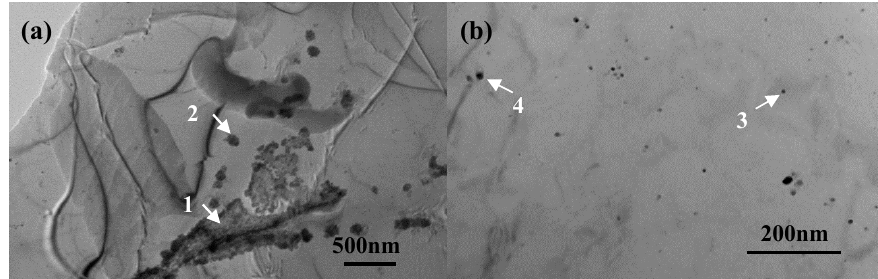
Figure 4. TEM images of the fusion zone of the 2060 Al–Li alloy laser welding metal. ( a , b ) are microstructure images of the grain boundaries and inner grains.